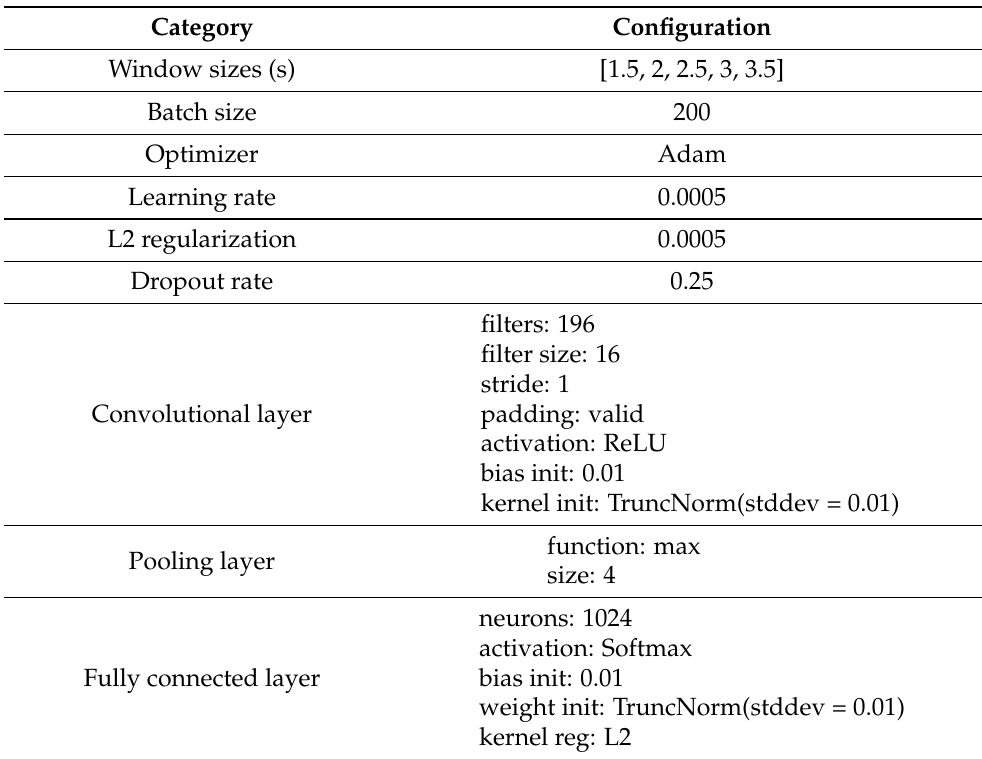
Table A3. UCI DTE CNN model configuration.